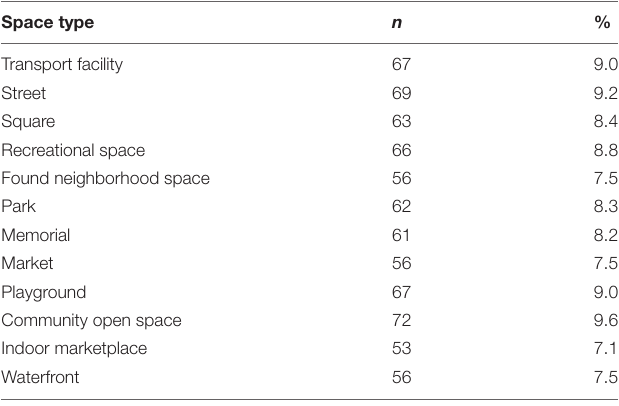
TABLE 3 | Sample sizes in Study